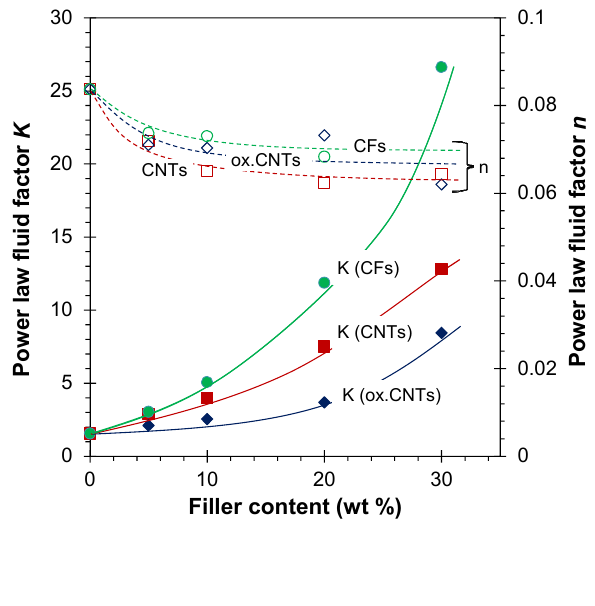
Figure 6. Power law fluid factors K and n , obtained by fitting the experimental Young’s modulus of the composite membranes with Equation (5) as a function of the filler loading. Lines are plotted as a guide to the